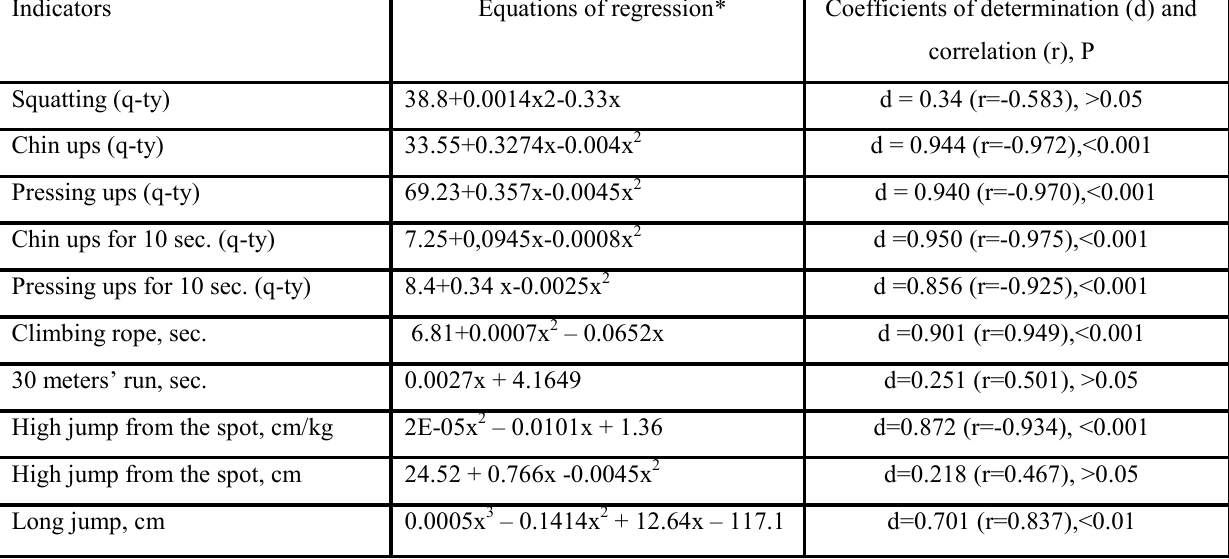
Regressive models of speed-power indicators’ dependence on wrestlers’ weight